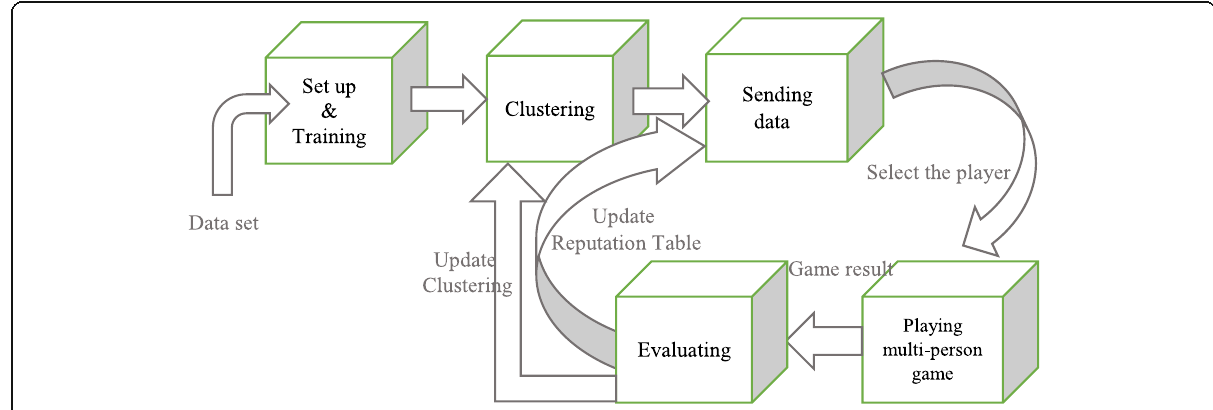
Fig 3 General diagram of the proposed